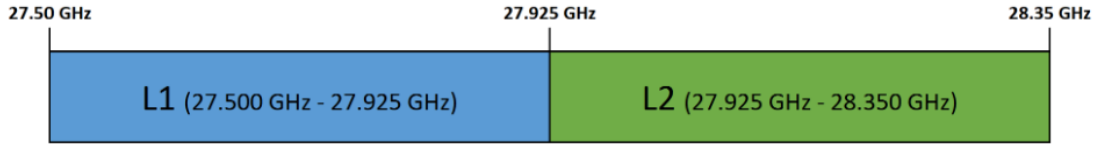
Figure 1. The 28 GHz (27.50–28.35 GHz) local multipoint distribution service (LMDS) spectrum.